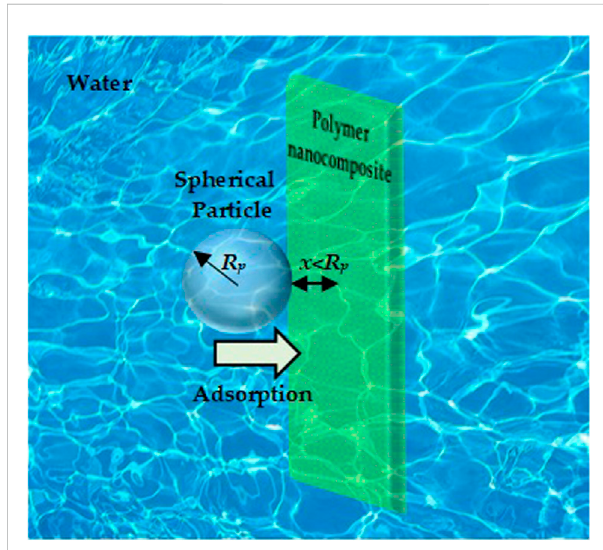
FIGURE 1 Schematic illustration of the physical adsorption: spherical particle adsorbate with radius R p located near fl at adsorbent nanocomposite surface in a water medium at separation distance ( x << R p